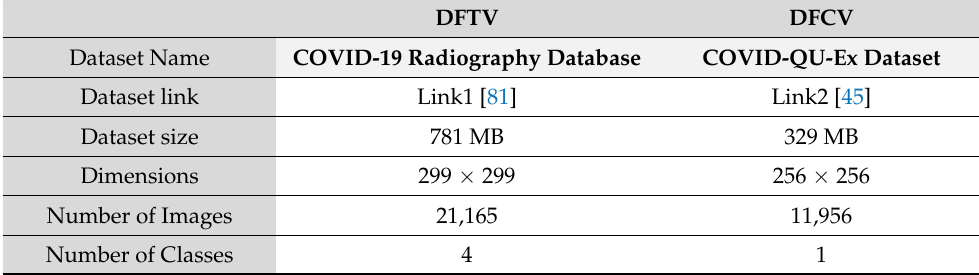
Table 2. Description of